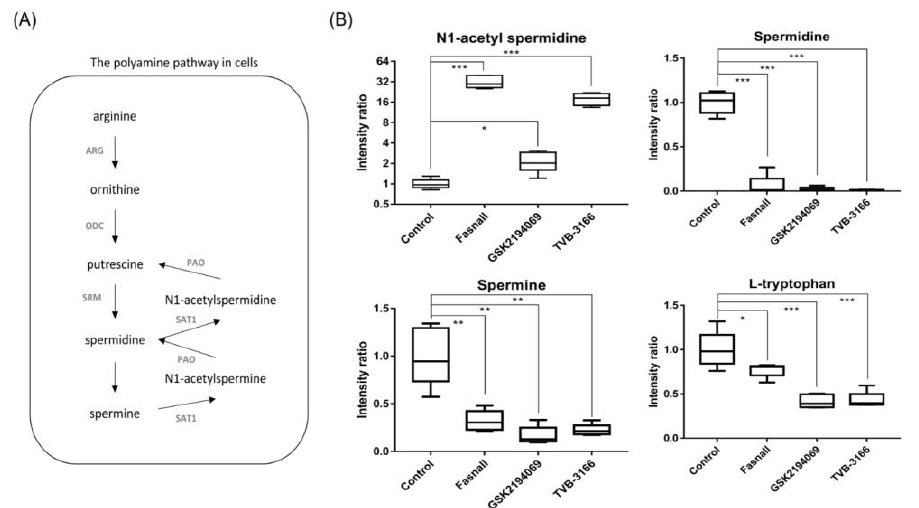
Figure 9. Polyamine pathway and box plots showing the fold change in the polyamine pathway metabolites. ( A ) The polyamine pathway shows metabolites involved in polyamine metabolism. ( B ) Box plots show the relative intensity ratio of polyamine metabolites and tryptophan with FAS inhibitors, (n = 5 per condition), *** p < 0.001, ** p < 0.01, * p < 0.05, Student’s t -test. N1-acetylspermidine is known to exist in a larger amount in tumor tissues, such as breast cancer and colorectal cancer, than in normal tissues due to an increase in the activity of spermidine / spermine N1-acetyltransferase (SAT1) [40,41]. Since acetyl-CoA is expected to accumulate due to FAS